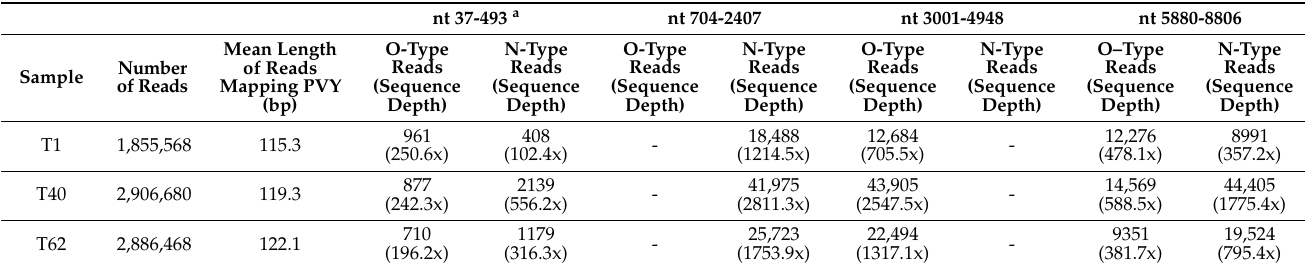
Table 3. Analysis of HTS data from the samples containing more than one PVY sequence variant. Partial sequences available in the Genbank databases under accession numbers MW595190–MW595207.